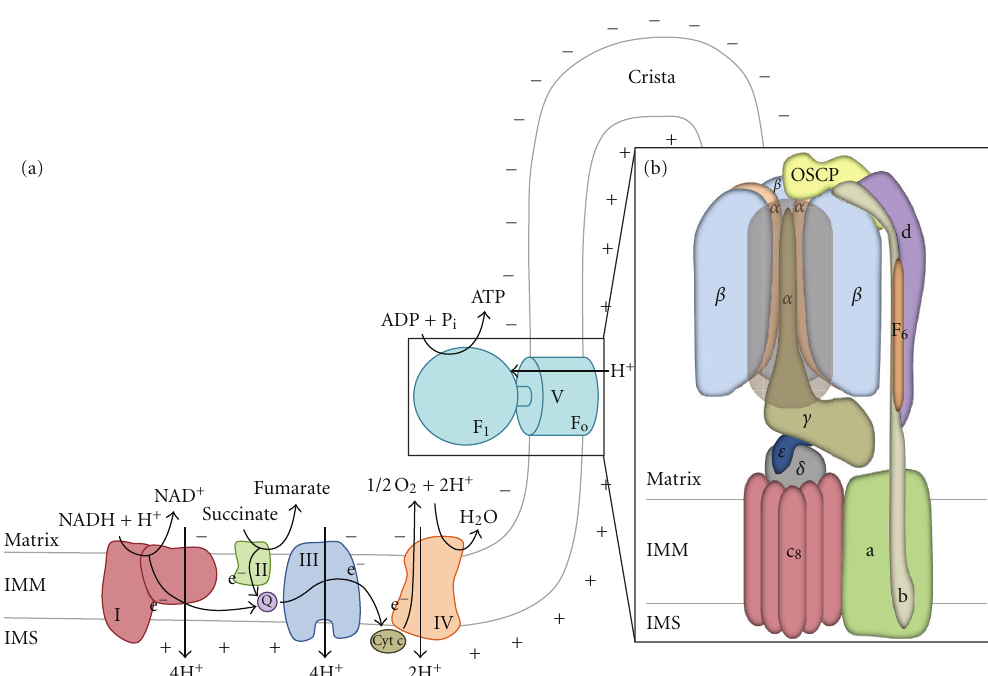
Figure 1: Oxidative phosphorylation and the mammalian F 1 F o -ATPsynthase. (a) Scheme of the mitochondrial OXPHOS: it is composed of five complexes, which couple the generation of a proton motive force through the mitochondrial inner membrane (IMM) with ATP synthesis. The first four complexes form the electron-transport chain (ETC), which catalyses the oxidation of NADH and FADH 2 to NAD + and FAD respectively, with the associated reduction of molecular oxygen, to which electrons are transferred, to water. During the process, protons are translocated against a gradient in the intermembrane space by complexes I, III, and IV; the generation of a proton electrochemical potential ( Δ μ H + ), also called proton motive force (pmf), is achieved, driving the ATP synthesis, which is catalyzed as the final step by the F 1 F o -ATP synthase (Complex V). The supramolecular organization of the respiratory chain, with the F 1 F o -ATPsynthase localized to mitochondrial cristae, where a higher surface density of protons is realized, allows a better enzymatic performance of complex V. (b) Diagram of the structure of mammalian F 1 F o -ATPsynthase. We can divide the enzymatic complex into 4 principal subdomains: a catalytic headpiece ( α 3 β 3 ), hosting the three catalytic sites for ATP synthesis (one in each β subunit), a proton channel ( ac 8 ) and two stalks, the central rotor ( γδε ) and the peripheral stator ( bd (F 6 )OSCP) that link the first two subdomains together. While protons flow through the F o channel from the intermembrane space into the matrix, a rotation of the stator inside the catalytic headpiece is induced, allowing a cyclic change in β -subunits conformation and the synthesis of ATP (N.B. Subunits A6L, e , f , and g are omitted in the